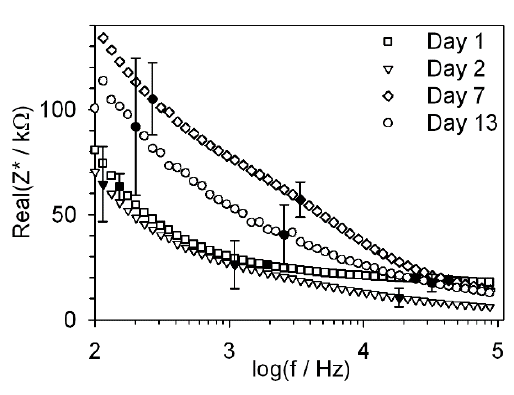
Figure 6: In vivo changes in Real(Z*) for bipolar electrodes in the frequency range of 100 Hz to 100 kHz over 13 days. A characteristic decrease at the second day after